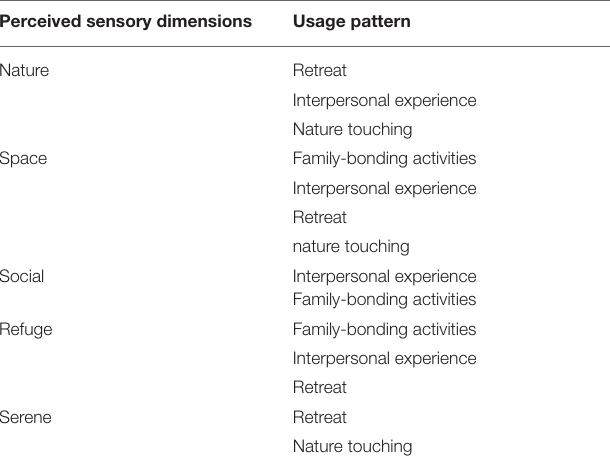
TABLE 9 | Pathways corresponding to each PSD linked